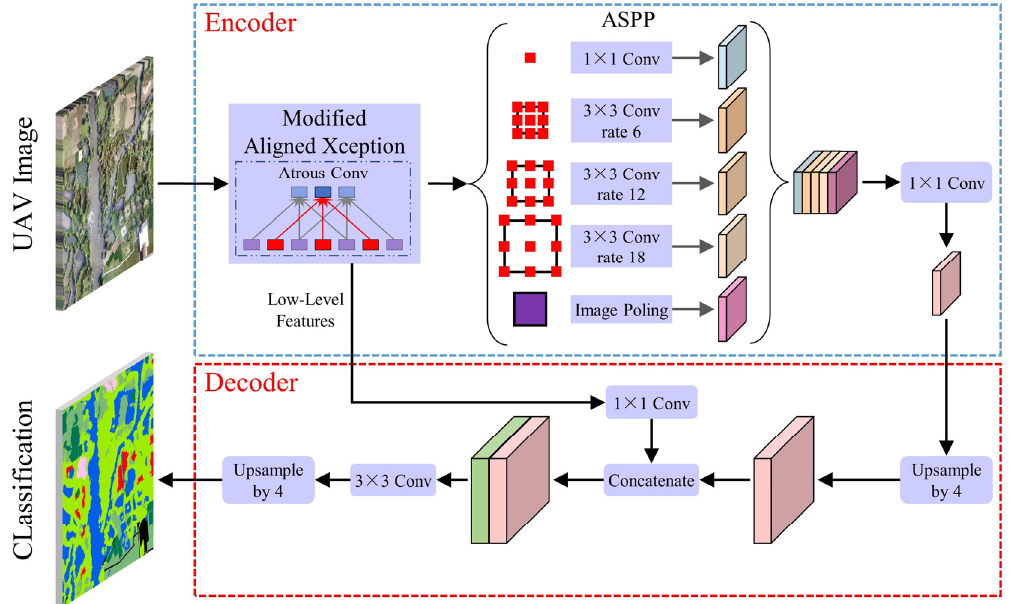
Figure 6. Structure of the DeepLabV3+ algorithm.